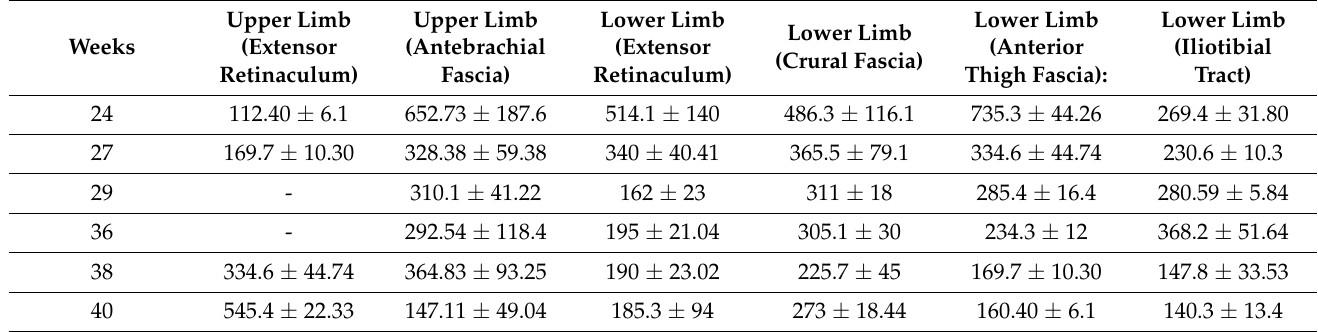
Table 1. Fascial reinforcement and deep fascia: the measurements are expressed in µ